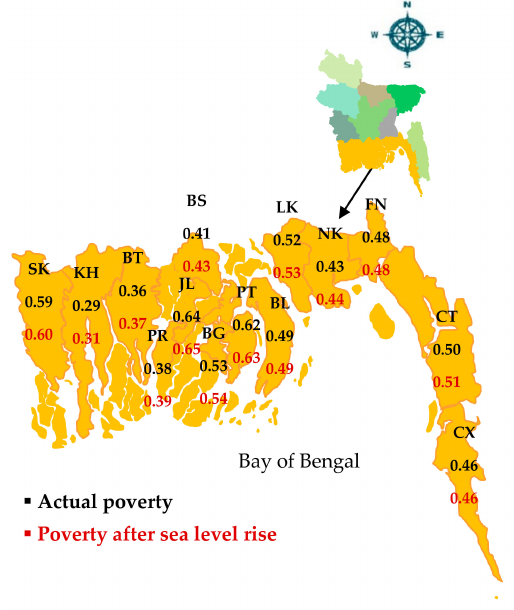
Figure 16. Changing poverty rate caused by sea level rise in southern